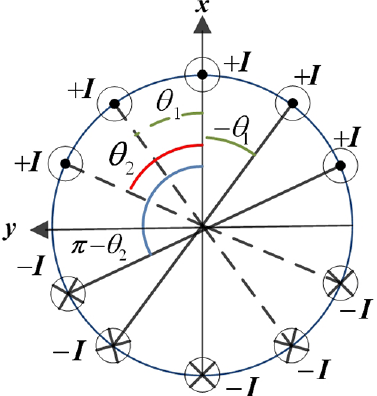
Figure 5. Electrical conductors of unknown angular positions ( θ ), flown by the same current I , distributed along the circumference.